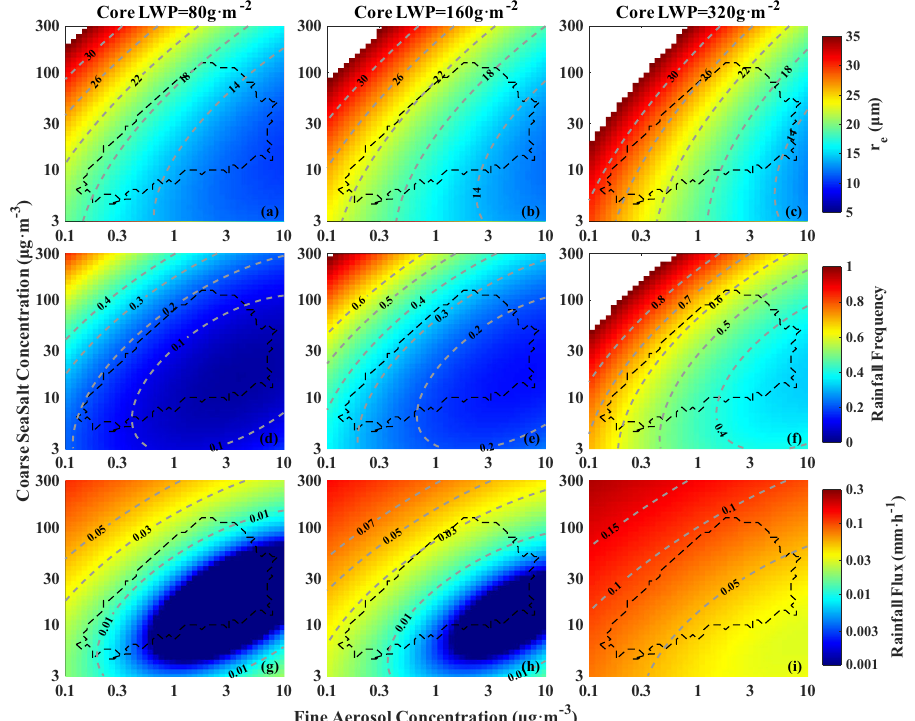
Fig. 6 Parameterization of warm rain variations driven by fi ne aerosol and coarse sea spray aerosols (CSA) at fi xed cloud liquid water path (LWP) based on the multiple non-linear regression model. The three rows indicate the predicted aerosol-driven variations of r e ( a – c ), rainfall frequency ( d – f ), and rainfall fl ux ( g – i ) under different constant LWP conditions. The three columns represent the low, moderate, and high LWP conditions, which are equal to 80, 160, and 320 g m − 2 , respectively. The gray dotted lines represent the contours of cloud or rainfall properties. The black dashed line indicates the distribution of the aerosols, with the sample size of each fi ne aerosol and CSA bins above 10, as same as the black dashed line in Fig.